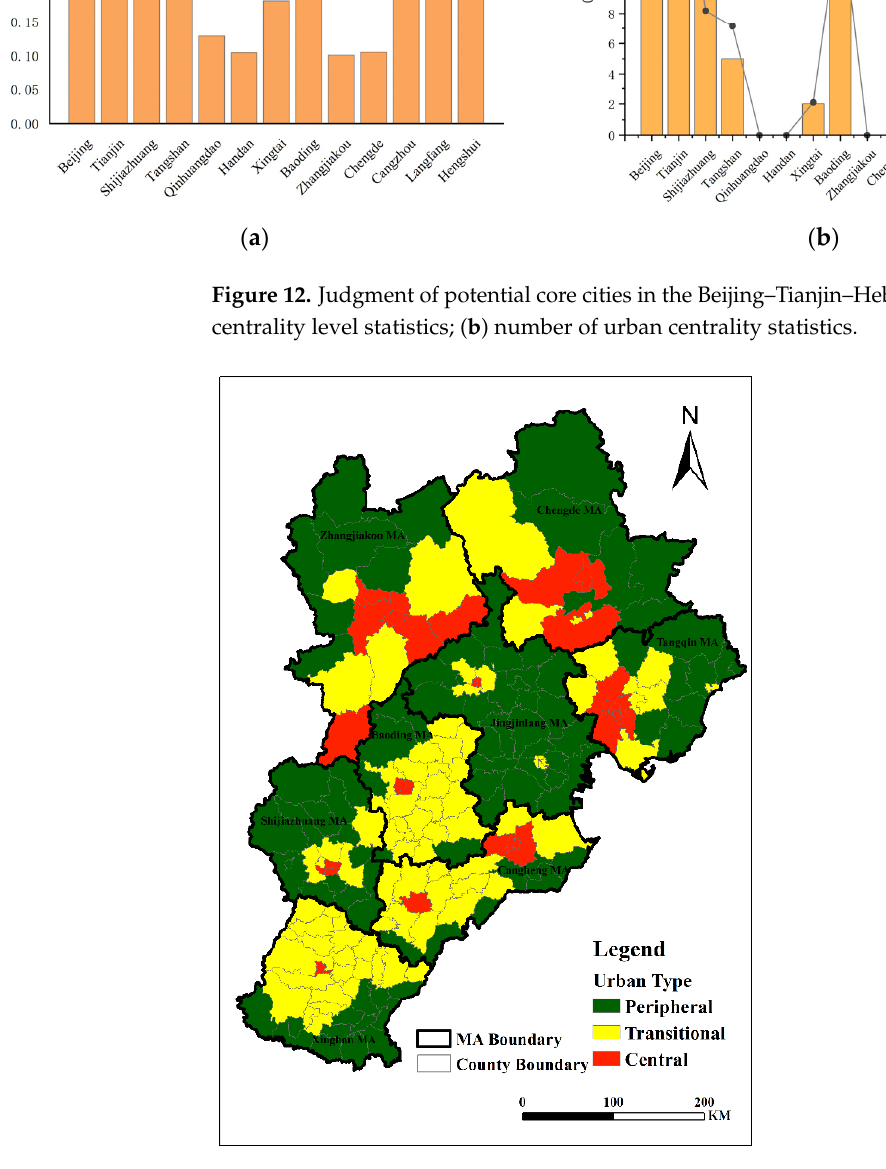
Figure 13. The “central-peripheral” structure of the MAs.